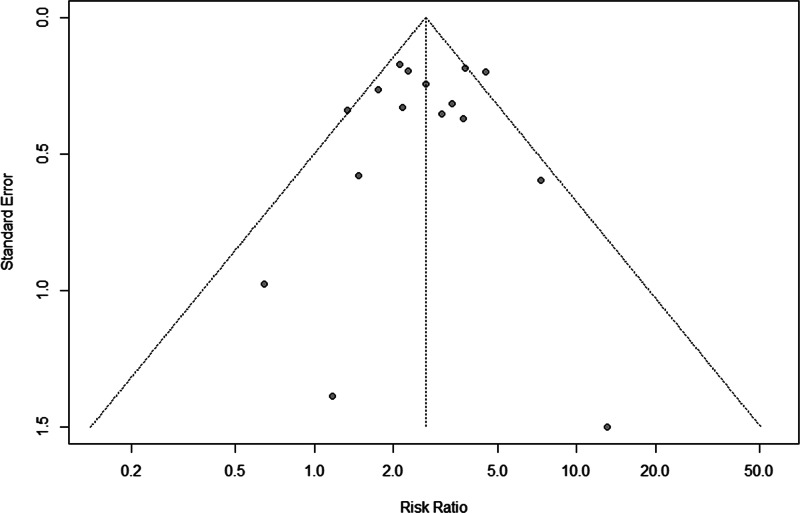
Funnel plot for the assessment of publication bias.